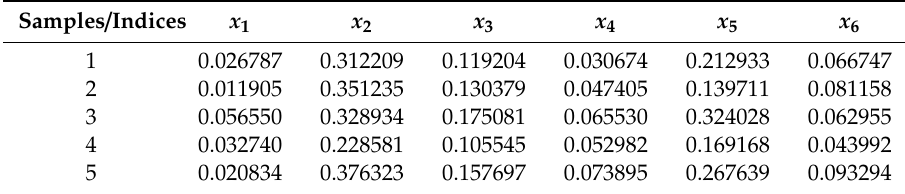
Table 5. Weighted normalized matrix.